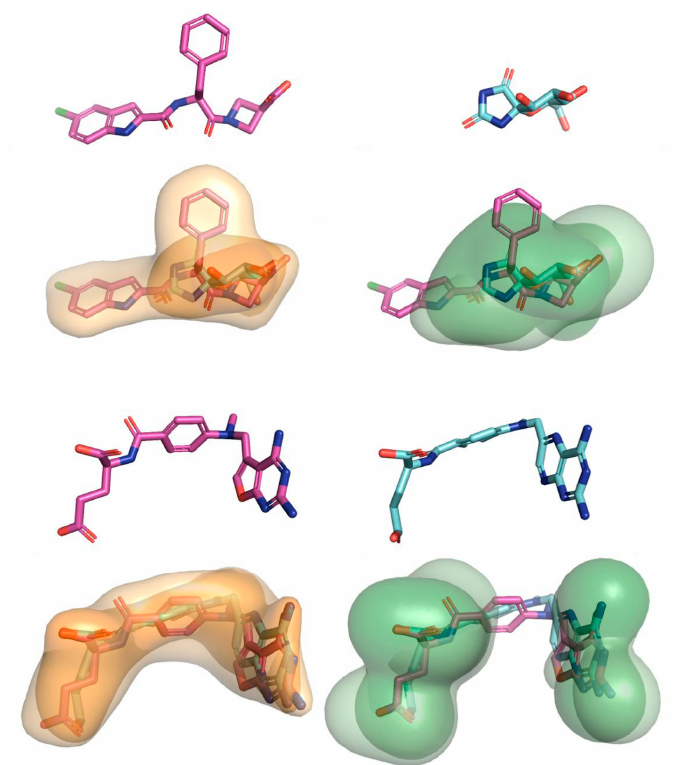
Figure 8. Representation of the hydrophobic molecular overlay exploited by PharmScreen. (Top) Representation of the hydrophobic molecular overlay exploited by PharmScreen.